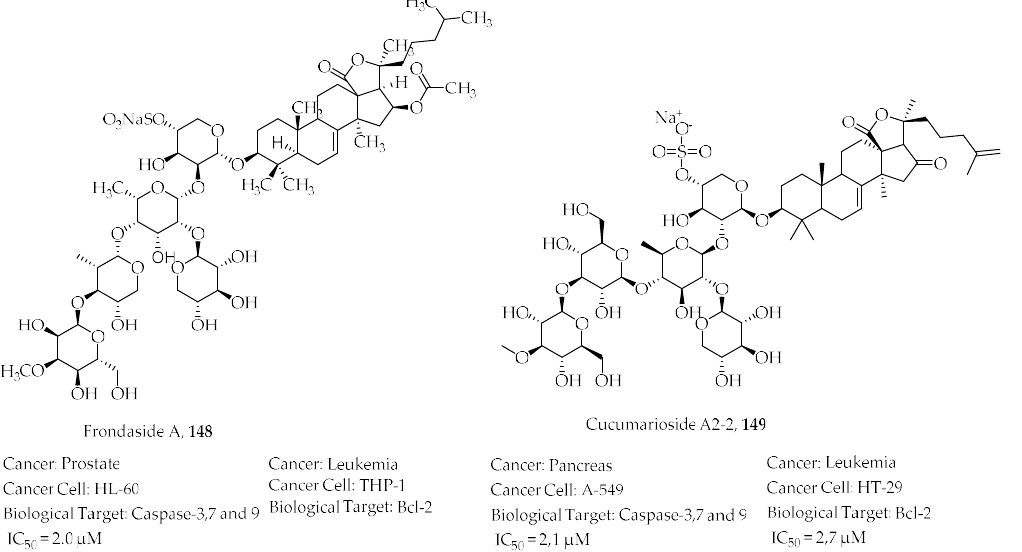
Figure 35. Structures of triterpenoid glycosides Frondaside A and Cucumarioside A2-2 with a summary of their biological activity towards selected cancer targets.